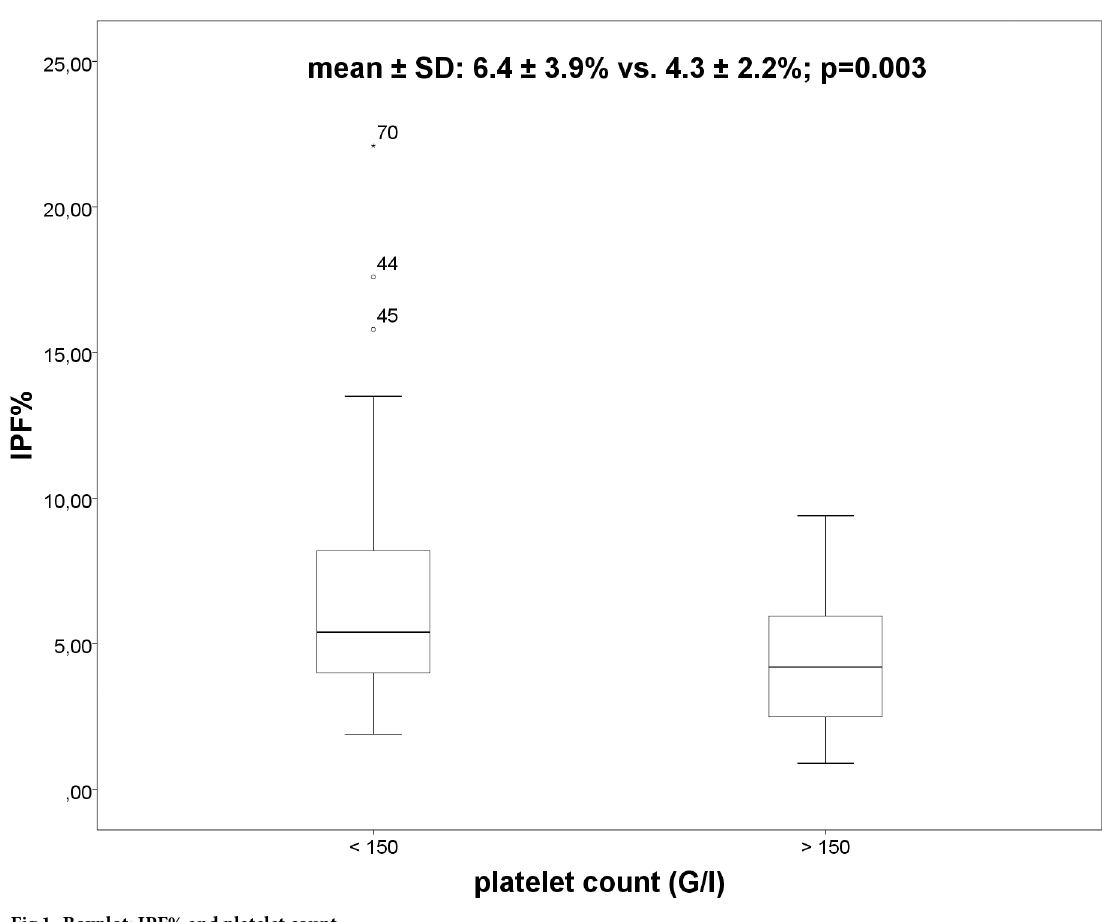
Fig 1. Boxplot: IPF% and platelet count. Overall, 59 patients had thrombocytopenia and 73 patients presented with splenomegaly. In patients with thrombocytopenia IPF% (6.4 ± 3.9% vs. 4.3 ± 2.2%; p = 0.003) (Fig 1) and